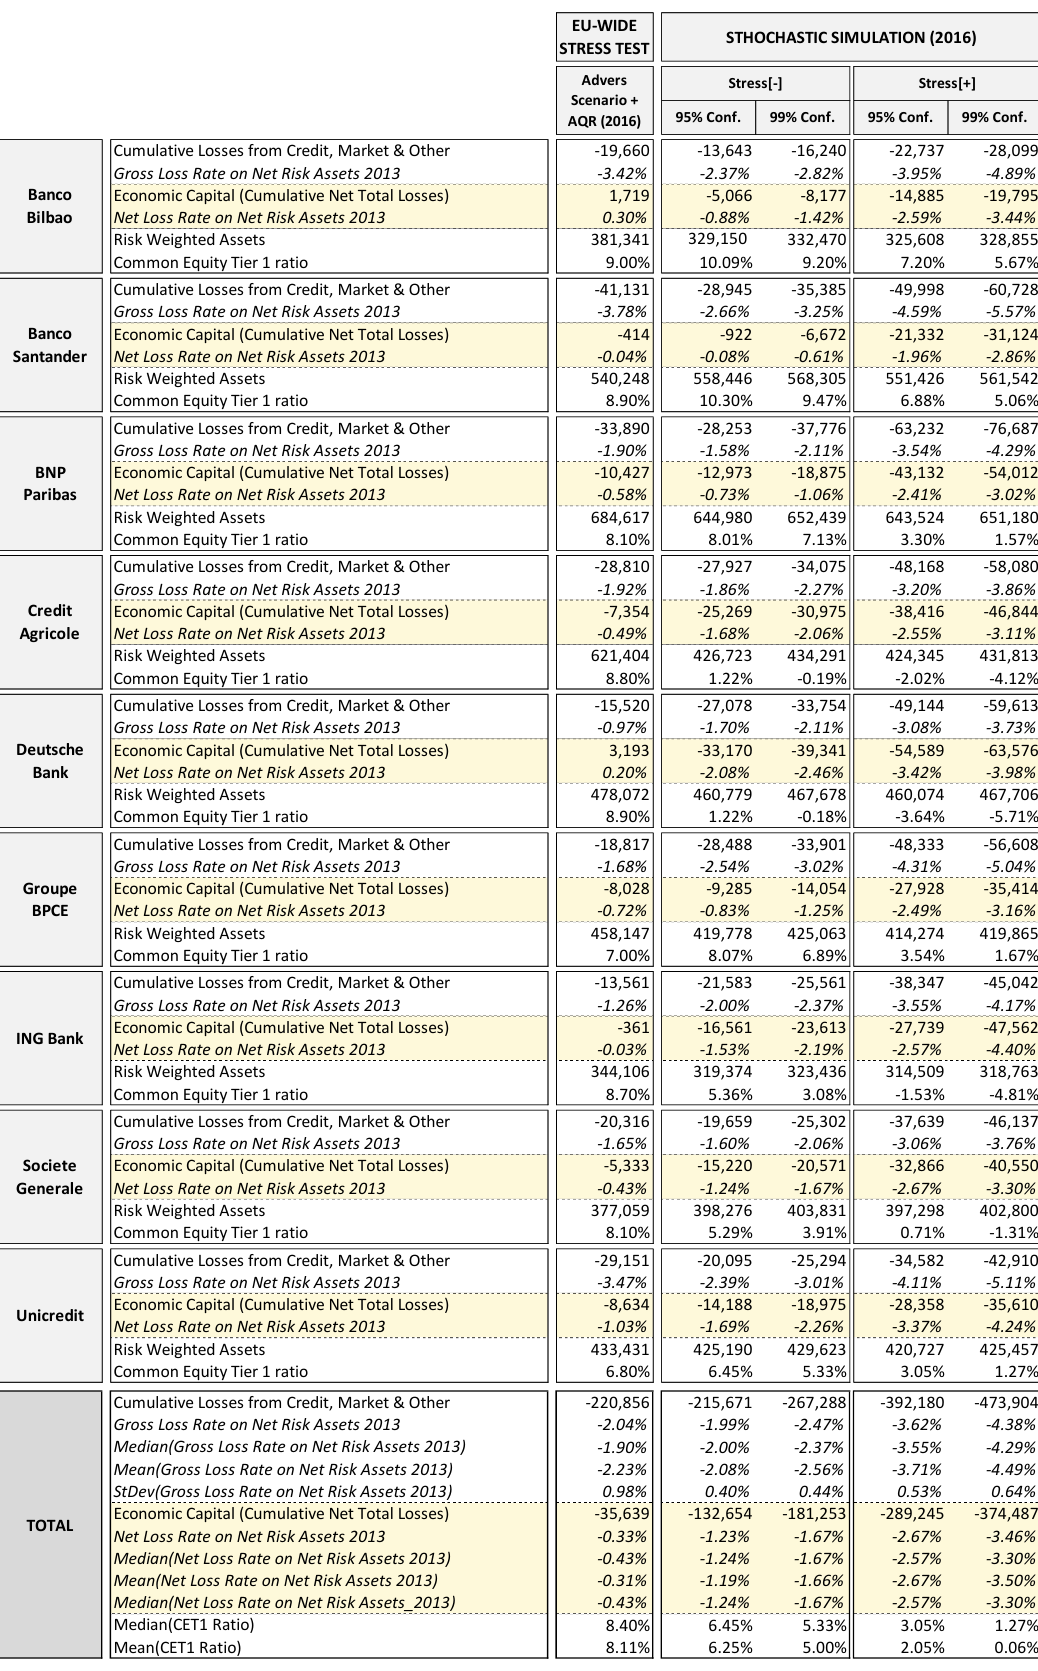
Figure 9. 2016 Stochastic simulation stress test vs. 2016 EBA/ECB comprehensive assessment. (Data in EUR millions/%). (Source of EU-Wide Stress Test: EBA and ECB 2014).